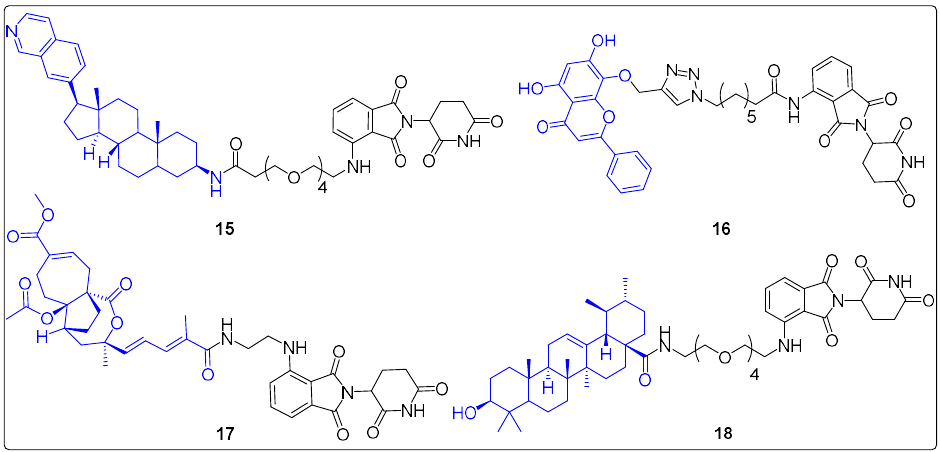
Figure 5. Natural products in PROTACs.